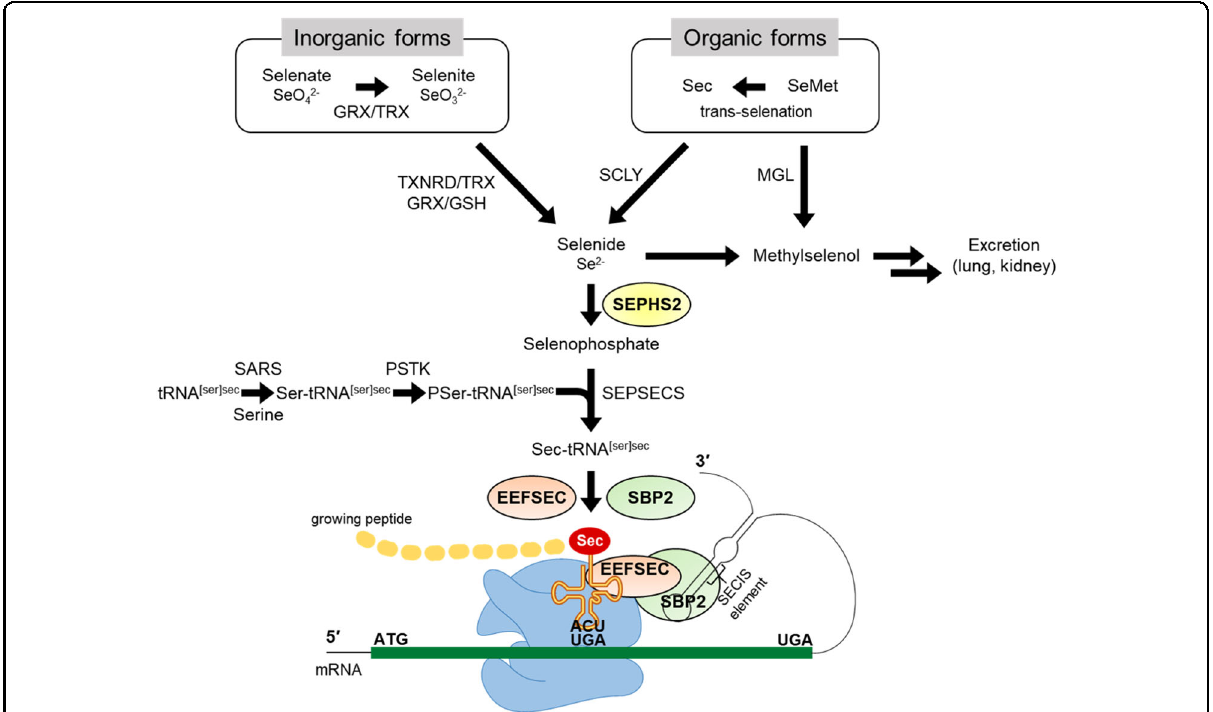
Fig. 1 Selenium metabolic system in mammals. Selenium is absorbed from the diet, undergoes several conversion steps, and is incorporated into polypeptide chains, completing selenoprotein synthesis. Dietary sources of selenium uptake exist in inorganic form such as selenate and selenite and organic form such as Sec and SeMet. Inorganic forms are reduced by TXNRD/TRX or GRX/GSH systems and organic forms are cleaved by SCLY, forming selenide. Selenophosphate is synthesized from selenide by SEPHS2, and the subsequent reaction with PSer-tRNA [Ser]Sec mediated by SEPSECS yields Sec-tRNA [Ser]Sec . Sec-tRNA [Ser]Sec is transferred to the A-site of ribosome mediated by SBP2, which binds to SECIS located in the 3 ′ UTR of a selenoprotein mRNA. Finally, the UGA codon is recognized as the Sec integration codon. Abbreviations: SeMet, selenomethionine; Sec, selenocysteine; GRX, glutathione reductase; TRX, thioredoxin; TXNRD, thioredoxin reductase; GSH, glutathione; MGL, methionine gamma-lyase; SCLY, selenocysteine lyase; SEPHS2, selenophosphate synthetase 2; SARS, seryl-tRNA synthetase; PSTK, phosphoseryl(Sep)-tRNA kinase; SEPSECS, Sep-tRNA: Sec-tRNA synthase; EEFSEC, Sec-speci fi c eukaryotic elongation factor; SBP2, SECIS binding protein